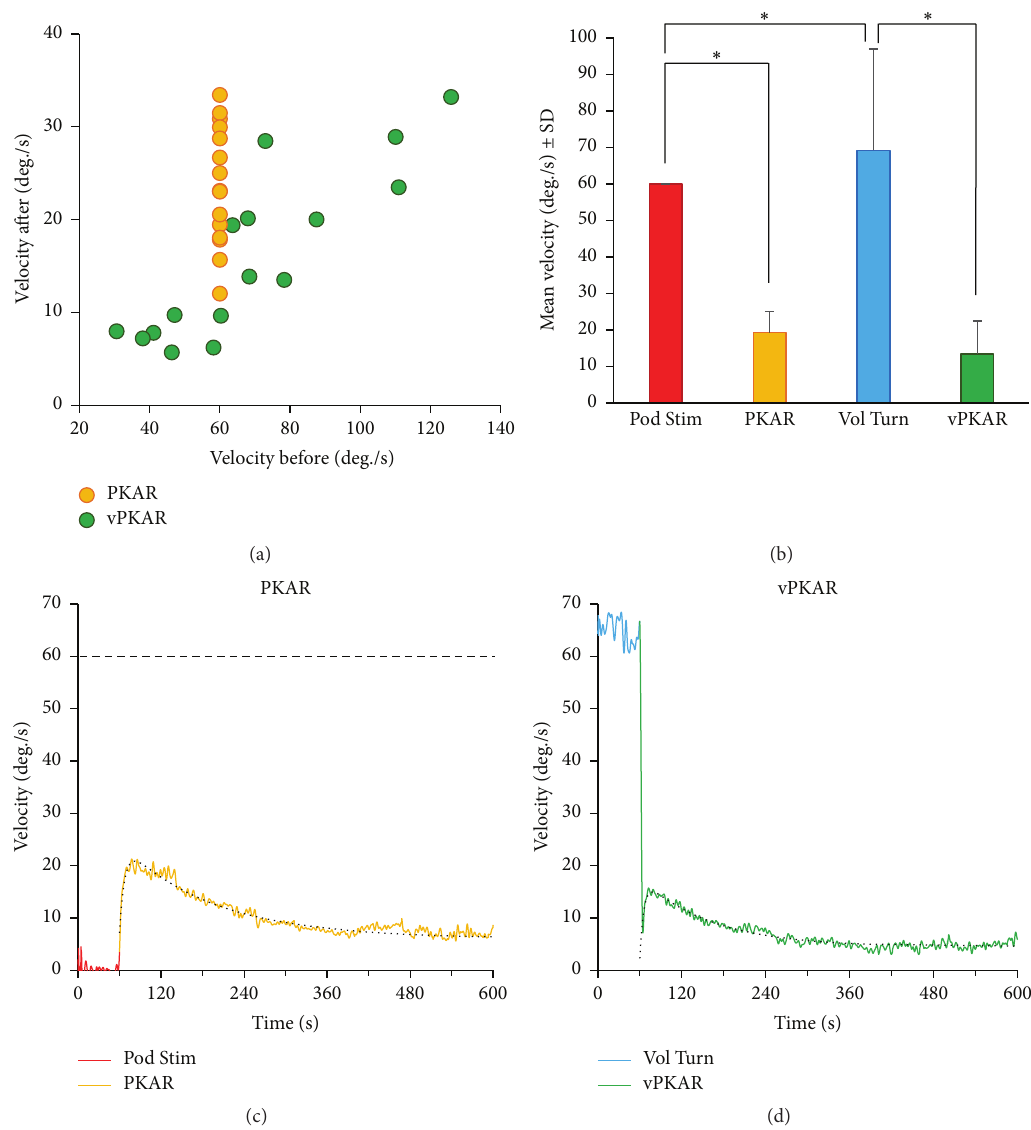
Figure 1: Posteffect of podokinetic stimulation and voluntary turning. In (a) the peak rotation velocity for each subject during the posteffect is plotted against the rotation velocity during the two conditioning procedures. (b) shows the mean angular velocity of the platform (Pod Stim) and of the body across subjects, during conditioning and posteffects. (c) shows the mean trace of the velocity of the body rotation (obtained by averaging the traces of all subjects) during the last minute of the podokinetic stimulation (Pod Stim, red colour, from 0 s to 60 s) and during the immediately following podokinetic after-rotation (PKAR, yellow color, 60 s to 600 s). The horizontal dashed line indicates the platform rotation velocity. (d) shows the angular velocity during the last part of voluntary turning (Vol Turn, blue, 0s to 60 s) and the posteffect (vPKAR, green, 60s to 600 s). The mean angular body velocity was almost null during Pod Stim but was more than 60 ∘ /s during Vol Turn (compare (c) and (d)). During the two posteffects, the mean velocities were just larger for PKAR compared to vPKAR but showed a similar initial rise and decay (the black dotted lines are the exponential fit). ∗ indicates significant difference ( 𝑝 < 0.05 ) between mean